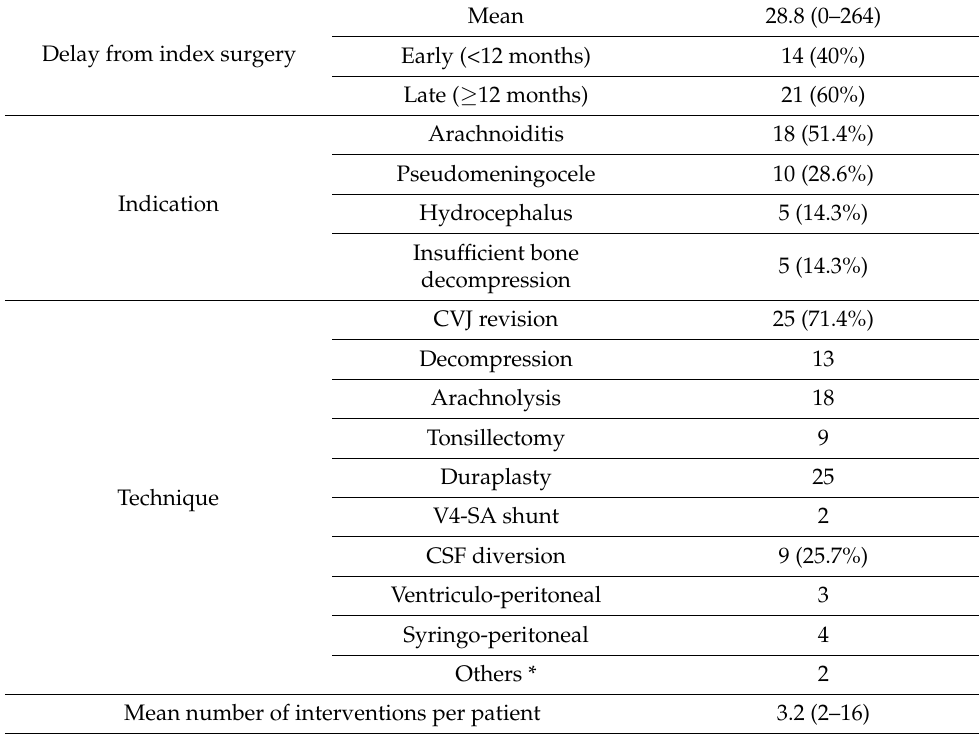
Figure 2. Craniovertebral junction revision after Chiari decompression failure. Case of a 39 years-old female patient initially operated on at another center for a Chiari I malformation without syringomyelia before index decompression surgery ( A ). Foraminal arachnoiditis and progressing syringomyelia ( B ), syringobulbia ( C ) and no CSF flow at the craniovertebral junction ( D ) 7 years postoperatively. CVJ revision was performed: bone decompression was enlarged, duraplasty was removed, and tonsilles were coagulated allowing resolution of the syringomyelia at 1 year postoperative ( E ). Table 2. Revision surgery: indication and